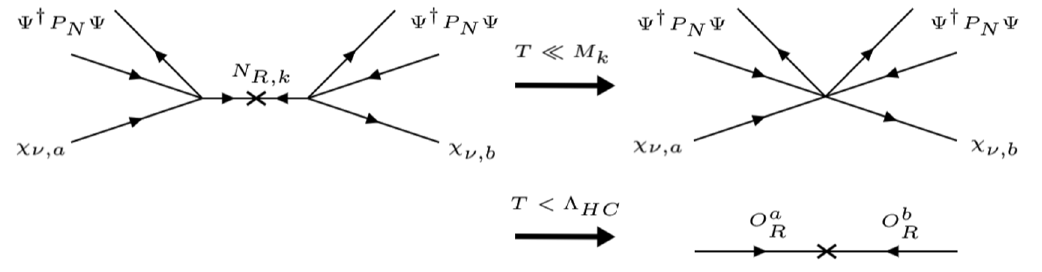
Figure 10 . The generation of the mixing terms of the right-handed neutrinos, N R,i , and their composite partners, O R,a , from the four-fermion interactions in eq. (A.7) when M i < m ∗ .